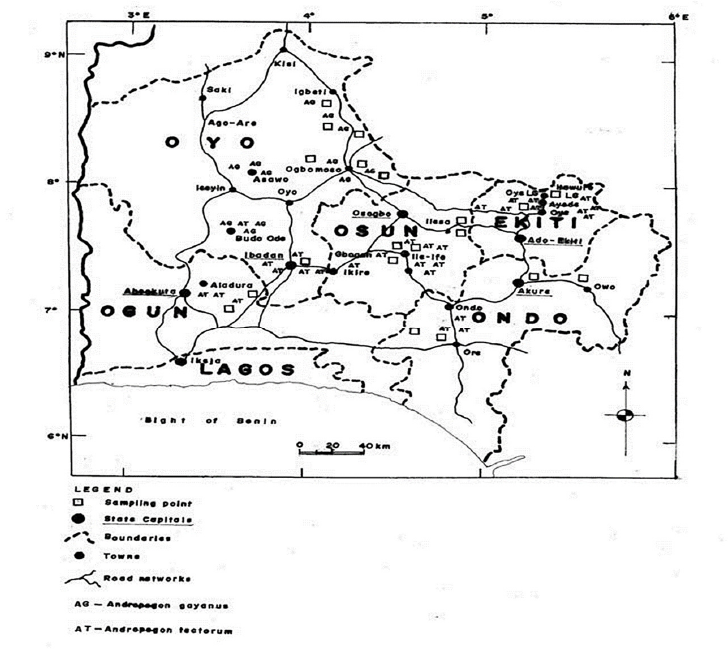
Figure 1. Map showing collection